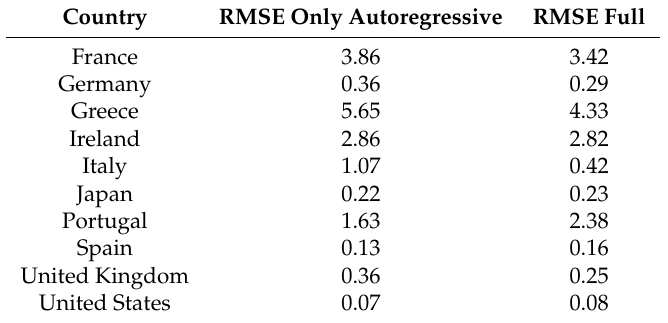
Table 4. August 2011: comparison between the root mean square errors (RMSE) obtained with a model composed by the solely autoregressive component (RMSE only autoregressive), and with our full structural VAR model (RMSE full). Country RMSE Only Autoregressive RMSE Full France 3.86 3.42 Germany